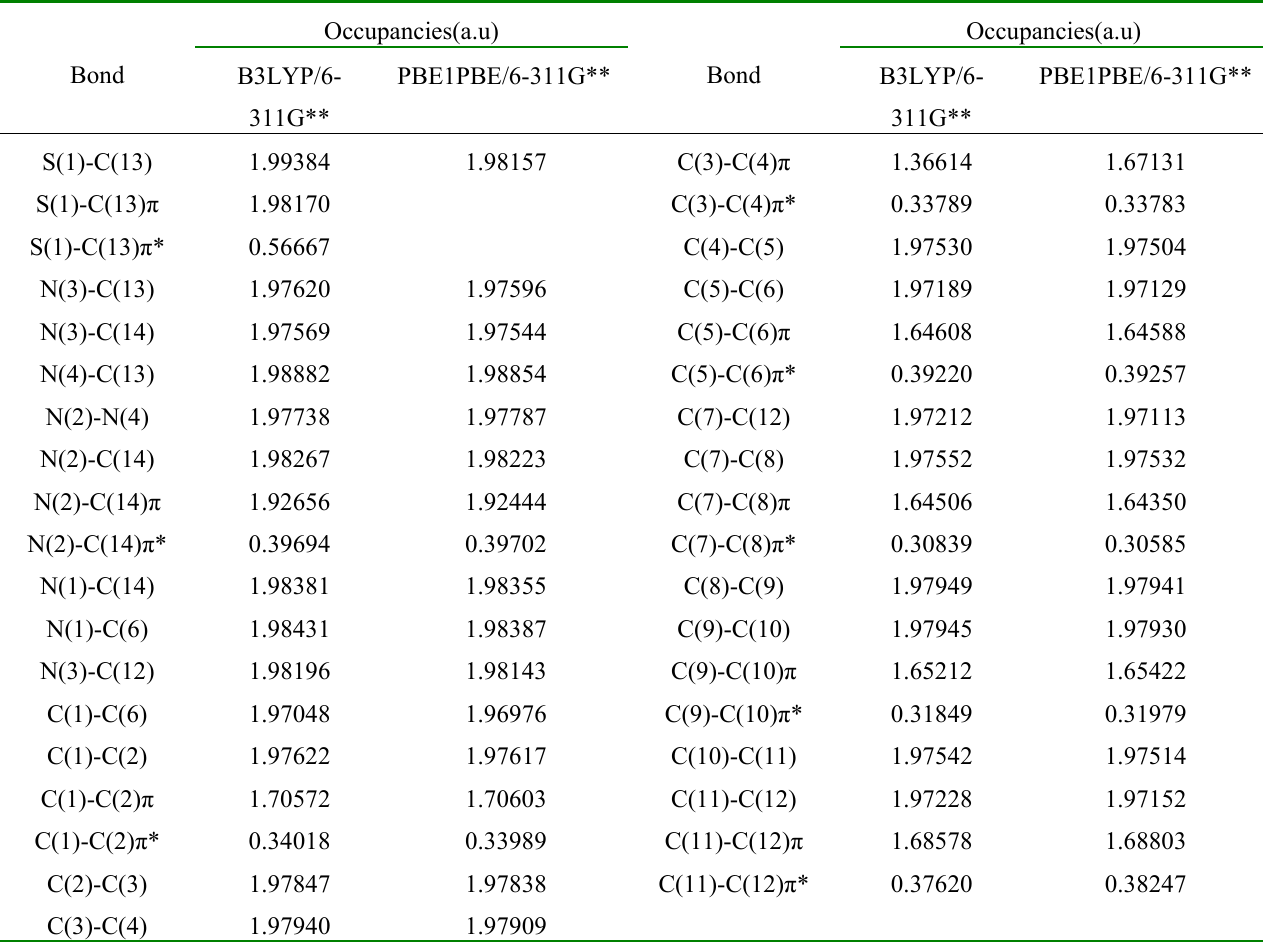
Table 3 . Natural bond orbital occupancies *